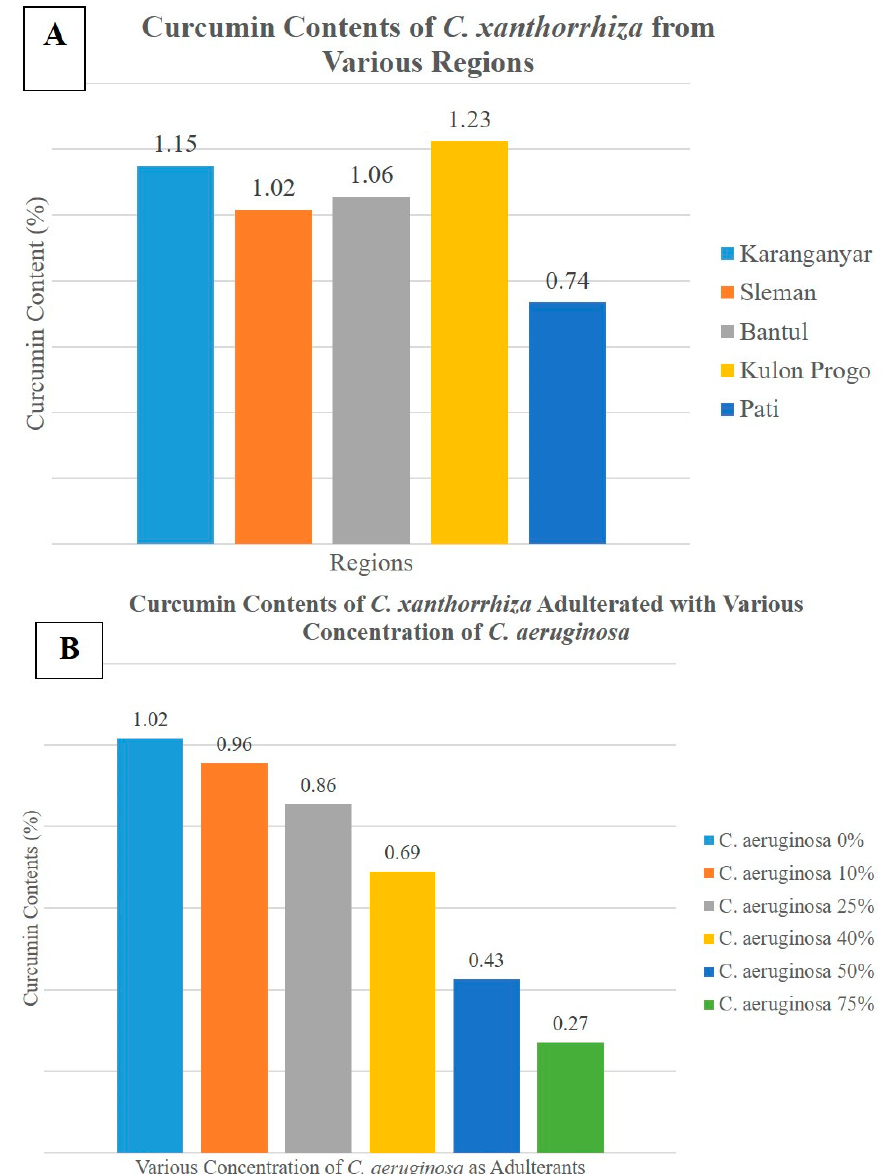
Figure 2. Curcumin contents of ( A ) C. xanthorrhiza from various regions; ( B ) C. xanthorrhiza adulterated